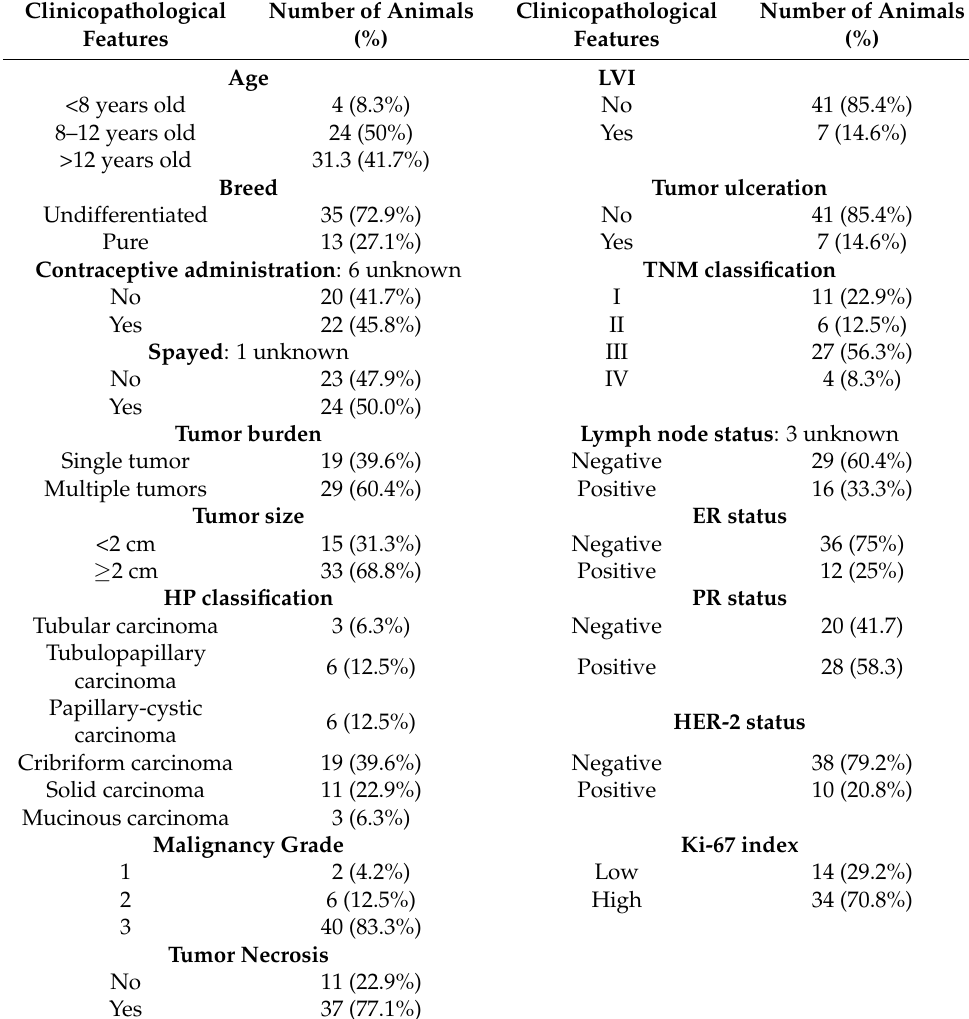
Table 1. Clinicopathological features of 48 cats with mammary carcinoma, enrolled in this